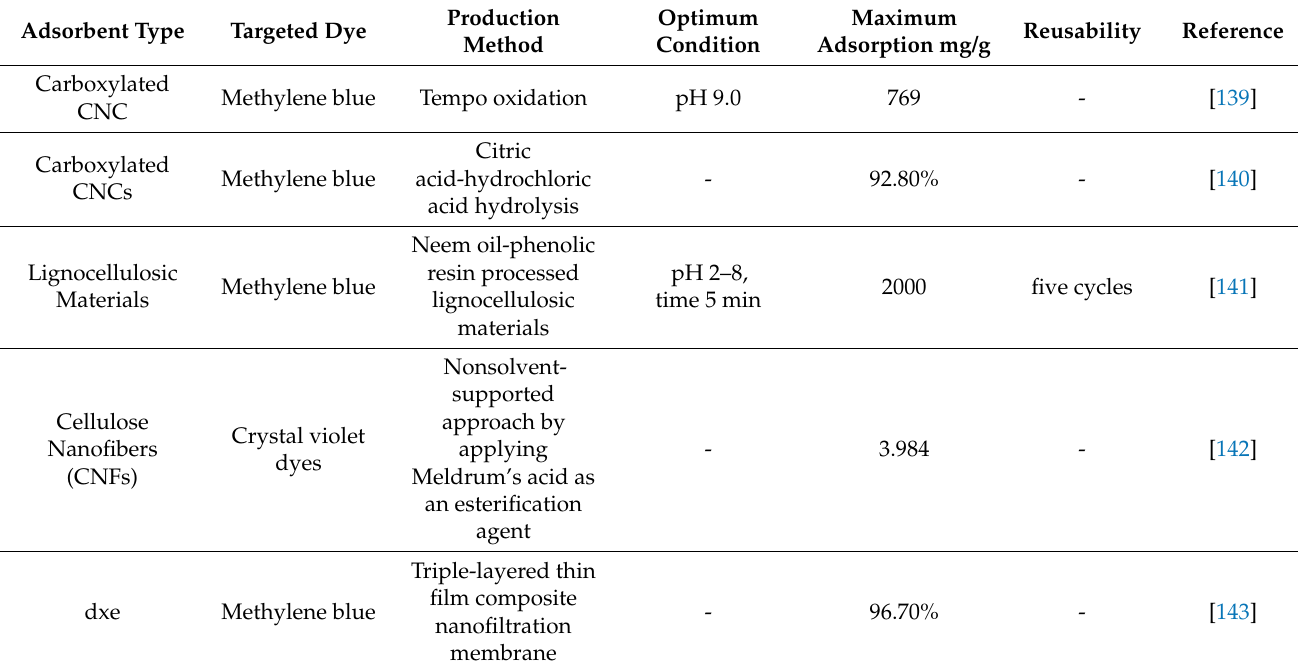
Table 4. Dye Removal using Nanocellulose Based